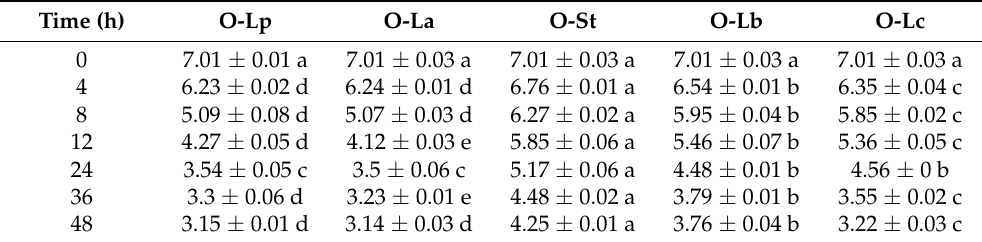
Table 1. Changes of pH of oat substrate during 48 h fermentation by different lactic acid bacteria. Time (h) O-Lp O-La